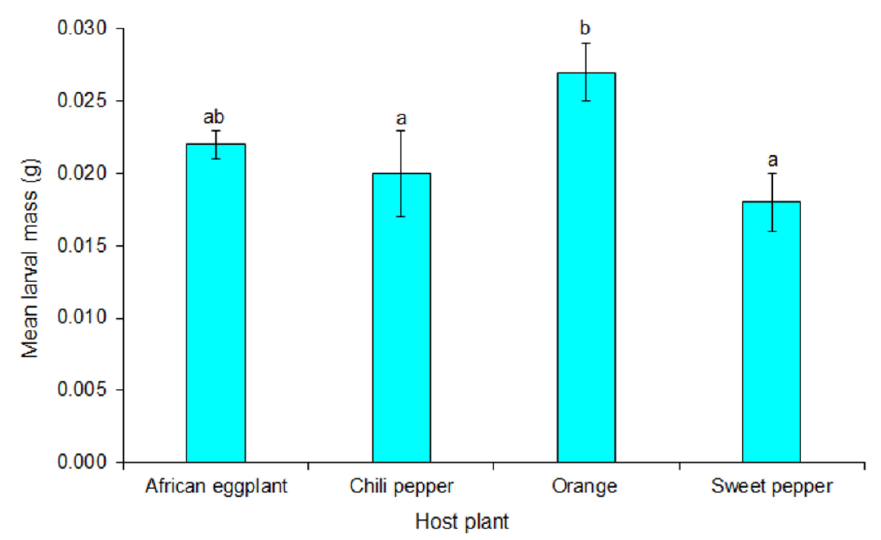
Figure 4. Mean mass (± SE) of final instar Thaumatotibia leucotreta larvae from orange and solanaceous vegetables. Bars caped with the same letter are not significantly different ( p = 0.05, Tukey’s HSD).